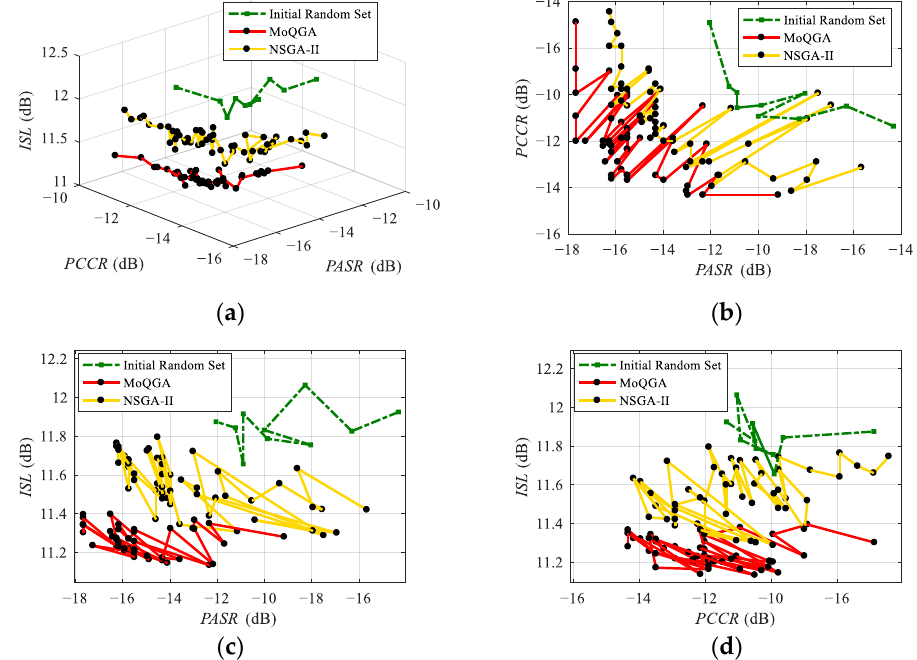
Figure 7. Pareto front obtained by MoQGA and NSGA-II when the parameters are M = 4, N = 64 and K = 4. ( a ) Pareto front; ( b ) PCCR - PASR of Pareto front; ( c ) ISL - PCCR of Pareto front; ( d ) ISL - PASR of Pareto front. Table 2. Objective functions values of Pareto front.